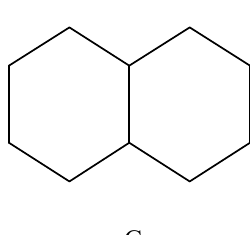
Figure 1. Graph G representing the carbon skeleton of